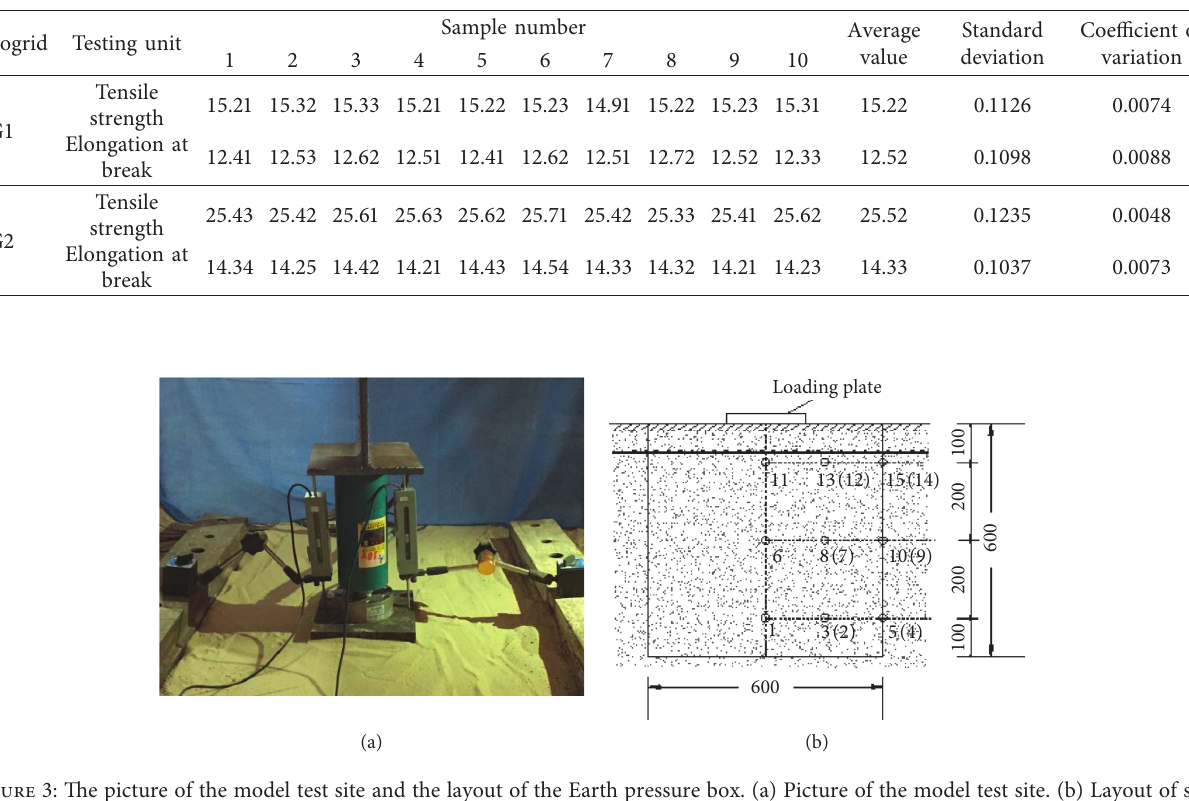
Table 3: Statistical analysis of tensile test data of geogrid.